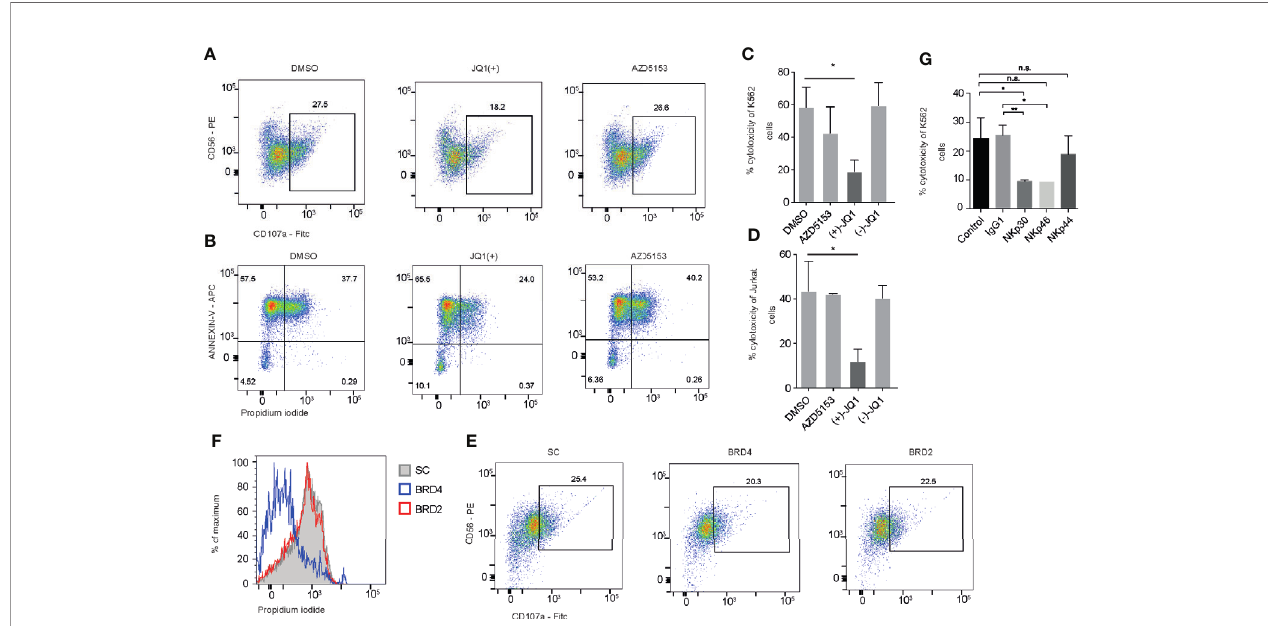
FIGURE 6 | BRD2 inhibition impairs NK cell killing function. (A) NK cells were stimulated with IL-15 (10 ng/ml) and then treated with DMSO, JQ1(+) or AZD5153 for 24 h. NK cells were then co-cultured with K562 cells for 4 h and CD107a was measured by fl ow cytometry (B) . Flow cytometry was also used to measure cell death in CD56 - K562 cells by measuring the expression of Annexin-V and propidium iodide uptake. (C) An LDH release assay was used to measure NK cell mediated cell lysis of K562 cells following 24 h of treatment with DMSO, JQ1( − ), JQ1(+) or AZD5153. (D) An LDH release assay showing the % cytotoxicity of Jurkat cells following 24 h of NK cell treatment with DMSO, JQ1( − ), JQ1(+) or AZD5153. (E) NK cells were cultured in the presence of scrambled control (SC), BRD2 or BRD4 LNA and then CD107a expression was measured following co-culture with K562 cells. (F) The level of killing of K562 cells was determined by measuring propidium iodide uptake. (G) Blocking antibodies against IgG1, NKp30, NKp44, NKp46 were added to NK cells stimulated with IL-15 (10 ng/ml). An LDH release assay was then performed and the % cytotoxicity of K562 cells was measured using an LDH release assay. (A, B, E, F) are representative of three independent experiments. (C, D, G) show mean ± S.D. of three independent experiments. P values were calculated using Kruskal – Wallis with Dunn ’ s multiple comparison test *P < 0.05, **P < 0.01. n.s., not signi fi